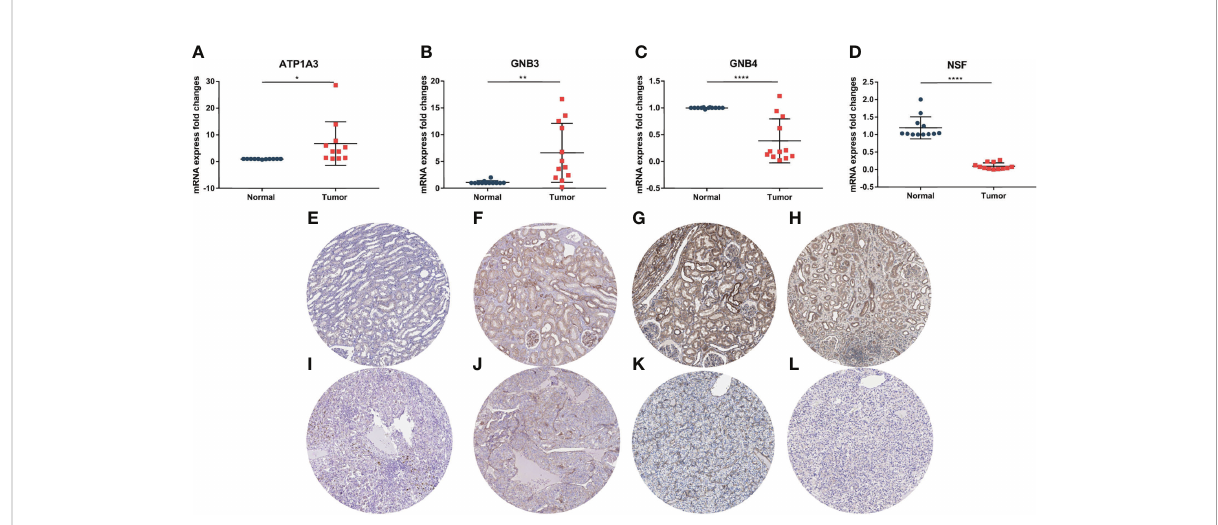
FIGURE 10 Expression of key genes in the PCRG prognostic signature in ccRCC and normal kidney tissues. The mRNA expression levels of ATP1A3 (A) , GNB3 (B) , GNB4 (C) , and NSF (D) in clinical samples were detected by qPCR. Immunohistochemistry of ATP1A3, GNB3, GNB4, and NSF in normal tissues (E – H) and ccRCC tissues (I – L) from the Human Protein Atlas (HPA)